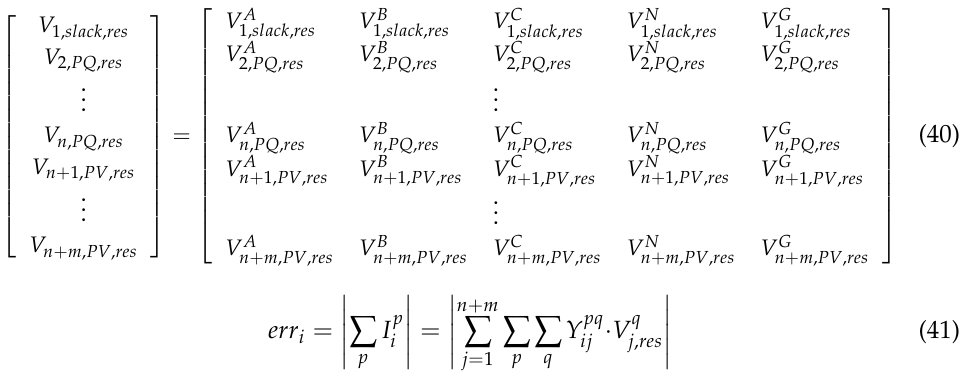
Figure 7, the error ( err i ) can be calculated from the current summation in Equation (41). If there is no error from LF results, the current summation must be zero.